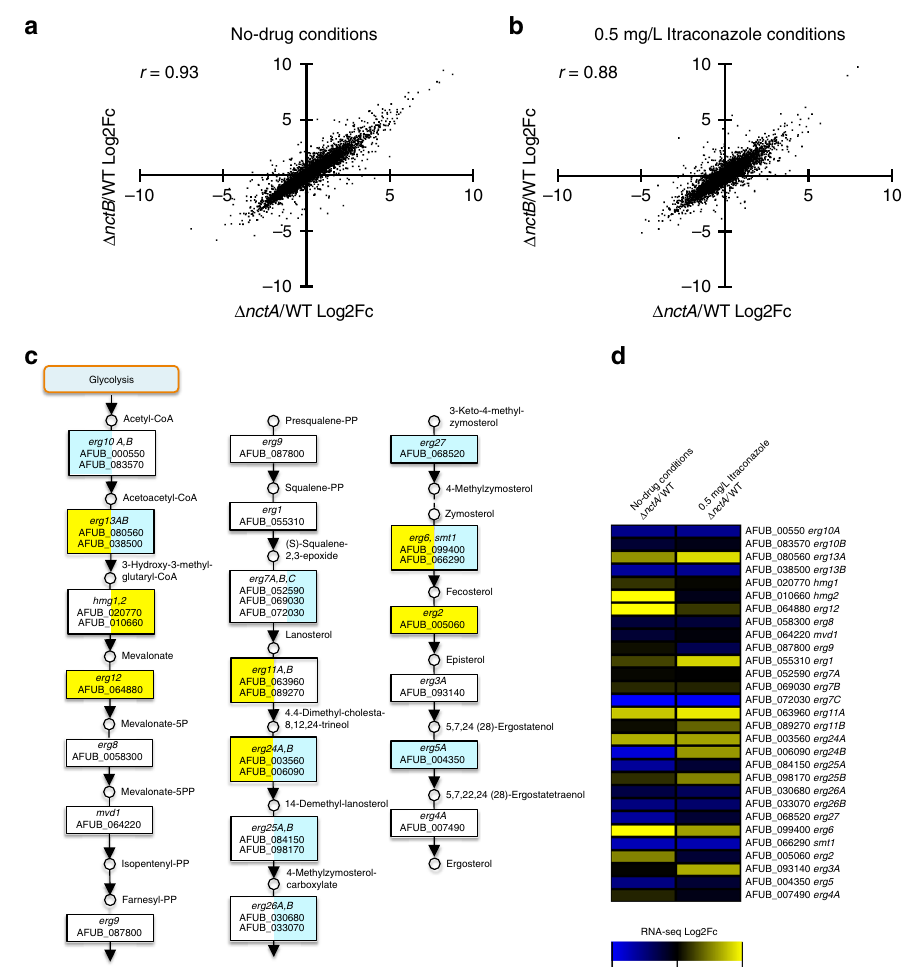
Fig. 3 Effects of nctA and nctB deletion on the global and the ergosterol biosynthetic gene expression. a , b Comparison of differential gene expression in the nctA and the nctB null mutants. Scatter plot comparison of the log2 differential expression ratio of gene expression data in ( a ) no-drug, and ( b ) 0.5mg/L itraconazole conditions. The log2 expression ratio between the nctA null mutant and the wild-type are plotted on the x -axis, and the nctB null mutant and the wild-type are plotted on the y -axis. The Pearson ’ s correlation ( r ) between the two gene expression data sets is shown. c , d Effects of nctA deletion on the expression of the genes involved in ergosterol biosynthesis. c The putative ergosterol biosynthetic pathway in A. fumigatus . The genes highlighted in yellow are those whose expression levels were upregulated more than 1.5-fold in the nctA null mutant compared with the wild-type. The genes highlighted in light blue are those whose expression levels were downregulated more than 1.5-fold in the nctA null mutant compared with the wild-type. b Heatmap showing the RNA-seq expression levels of the genes involved in ergosterol biosynthesis. Log2 differential expression values are scaled between − 1.5 and 1.5, and displayed. Source data are provided as a Source Data fi